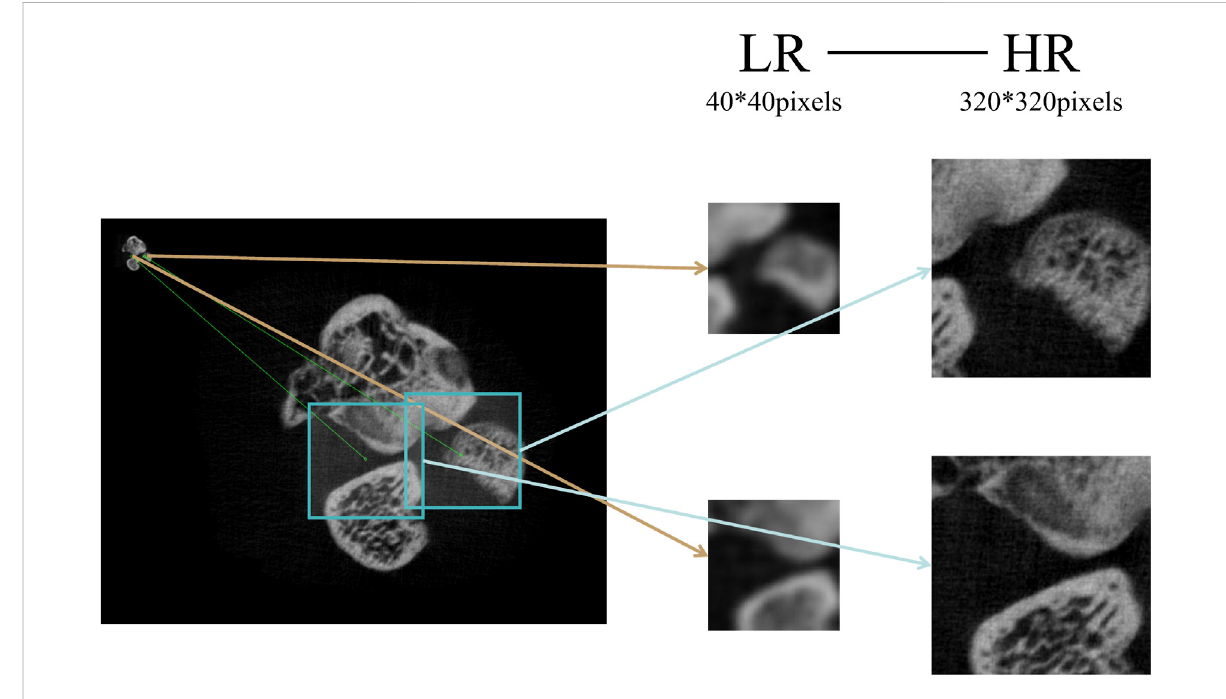
FIGURE 1 LR-HR image pairs are made based on image feature point